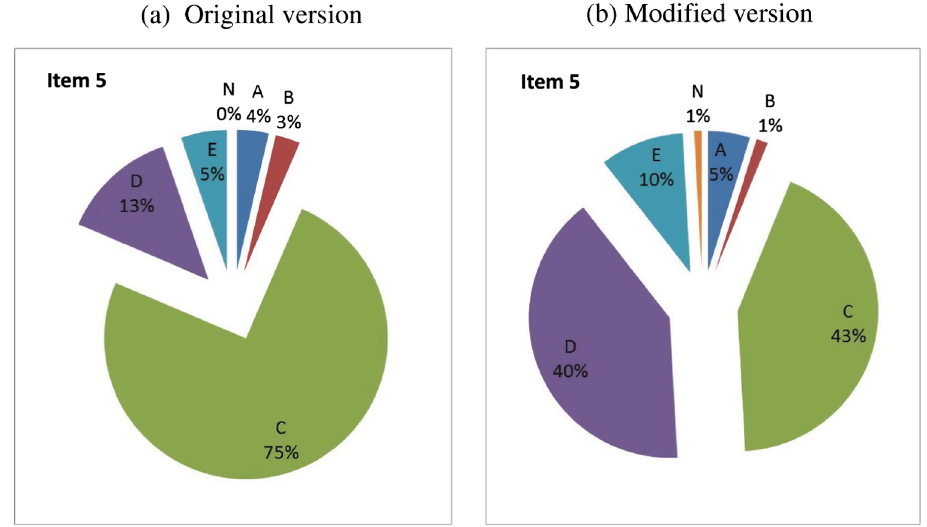
FIG. 2. Students ’ results with item 5 of the original and modified